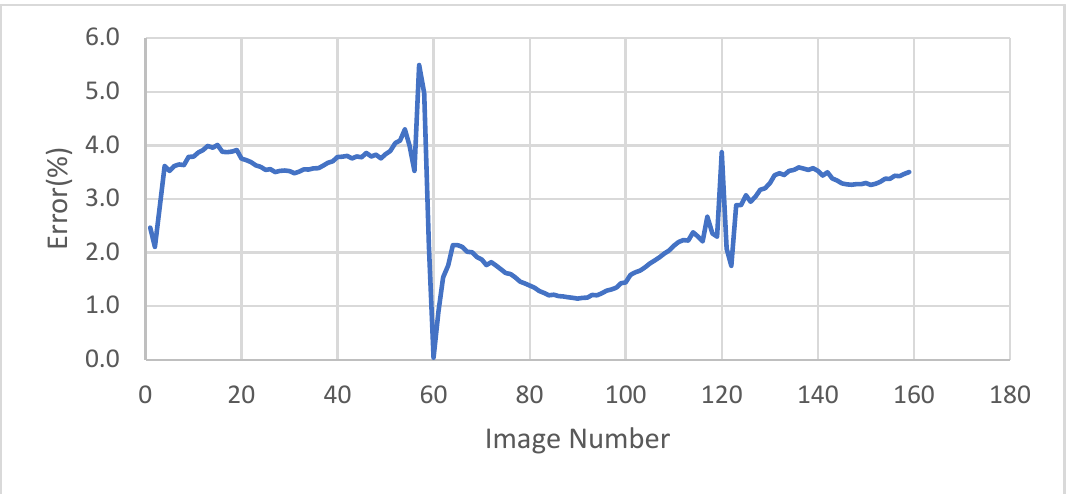
Figure 5. Error time history of the test on tracking the MTS machine movement.